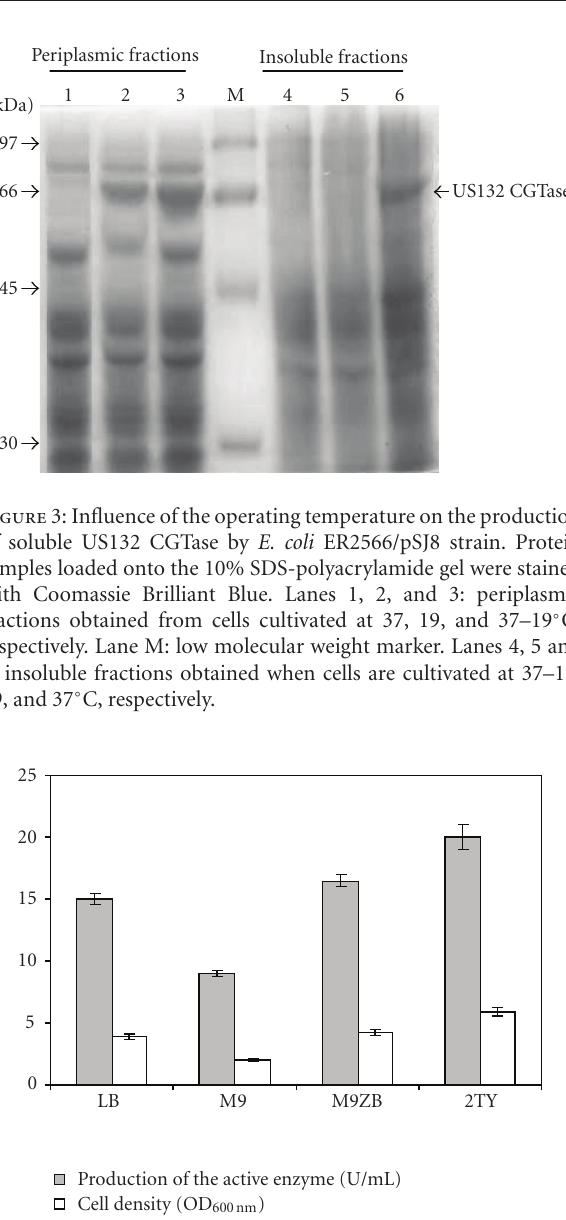
Figure 4: Influence of the growth medium on the active US132 CGTase production and the cell density of E. coli ER2566/pSJ8 strain. The temperature was shifted from 37 to 19 ◦ C after induction with 16 mg/L of IPTG when OD 600nm reached 0.8–1.